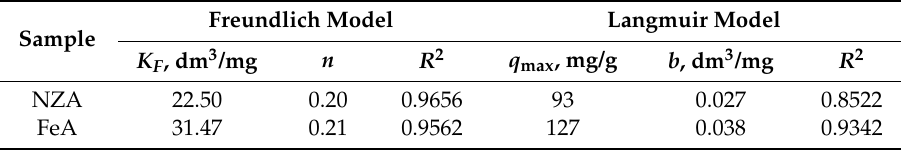
Table 6. Characteristic parameters of the Freundlich and Langmuir isotherms.